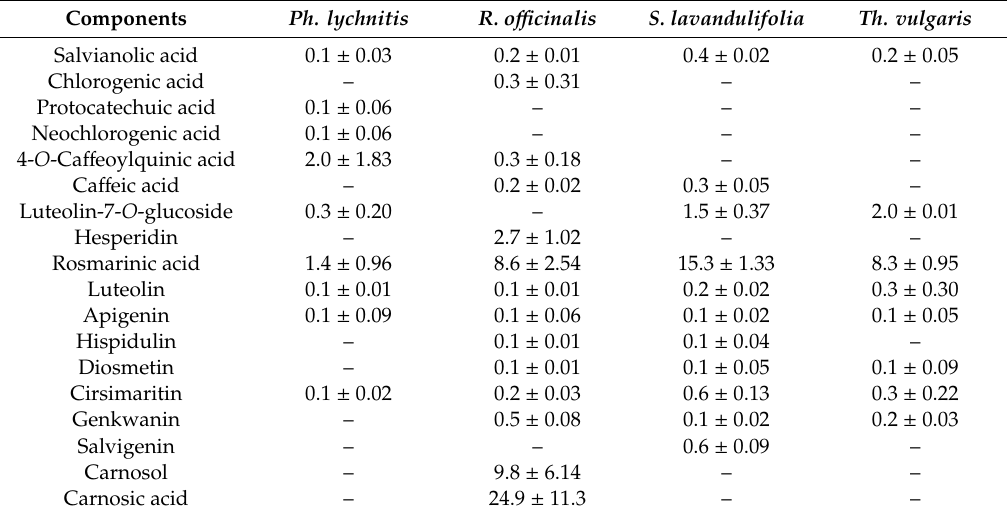
Values are means ± SD of three independent replicates from three di ff erent samples of each species. – not detected. Table 3. Major polyphenolic compounds quantified in the shrub pasture species belonging to the Labiatae family (mg / g of dry